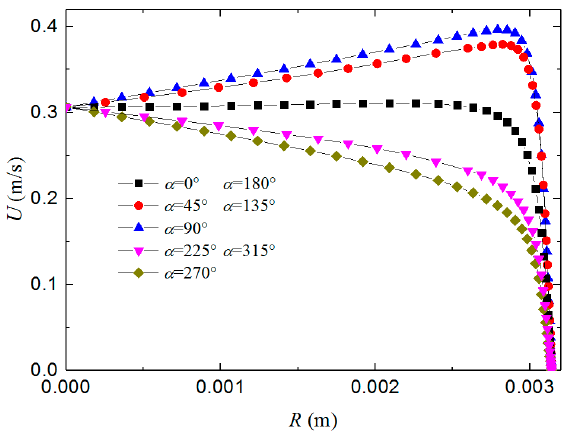
Figure 8. Case D2 velocity profile in the location of x/D=30 .